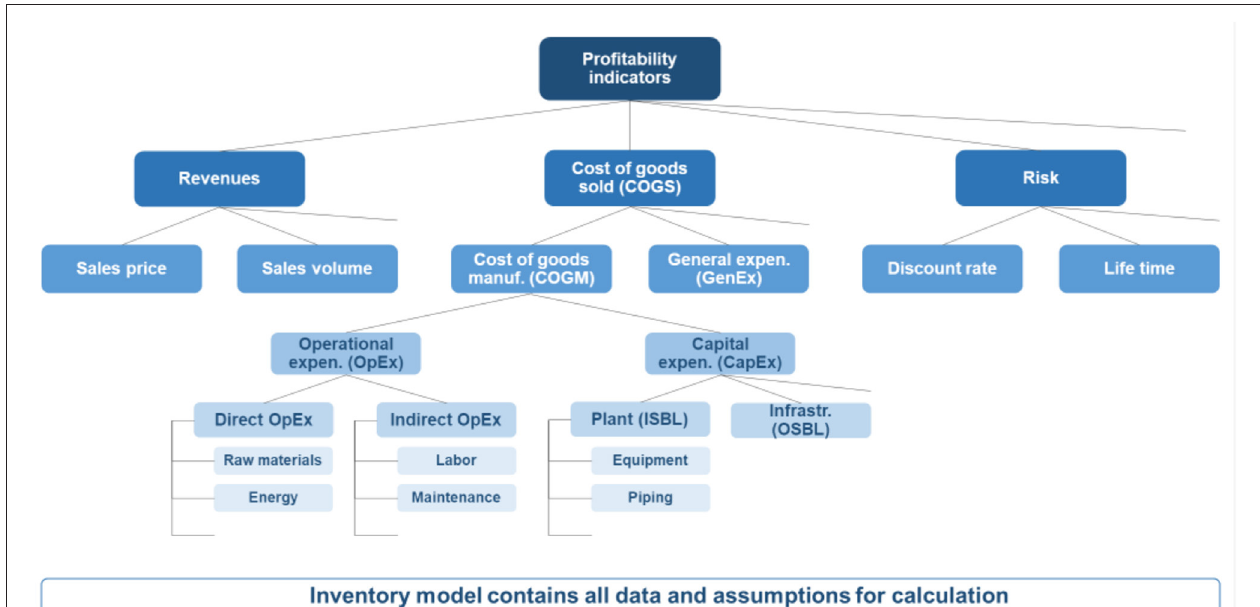
FIGURE 7 | Calculation hierarchy for economic indicators, adapted from Buchner et al.